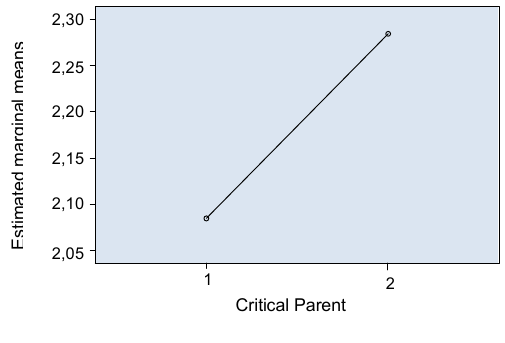
Figure 3: Estimated marginal means of MEASURE 1; Critical Parent